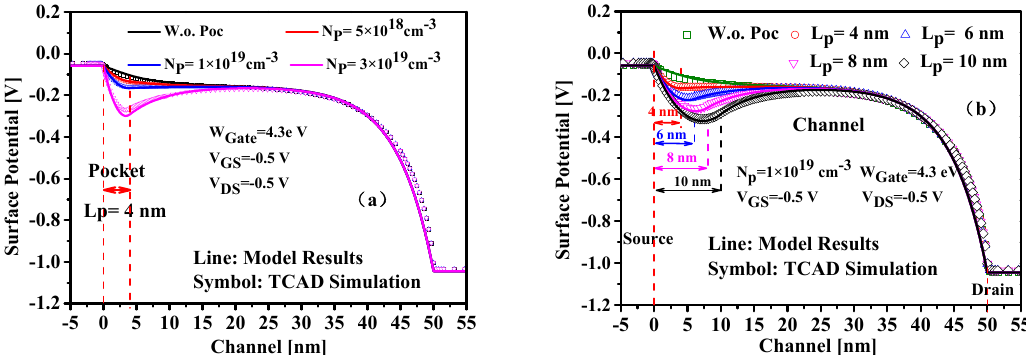
Figure 5. Surface Potential along the channel with ( a ) the pocket doping concentrations and ( b ) the pocket lengths.